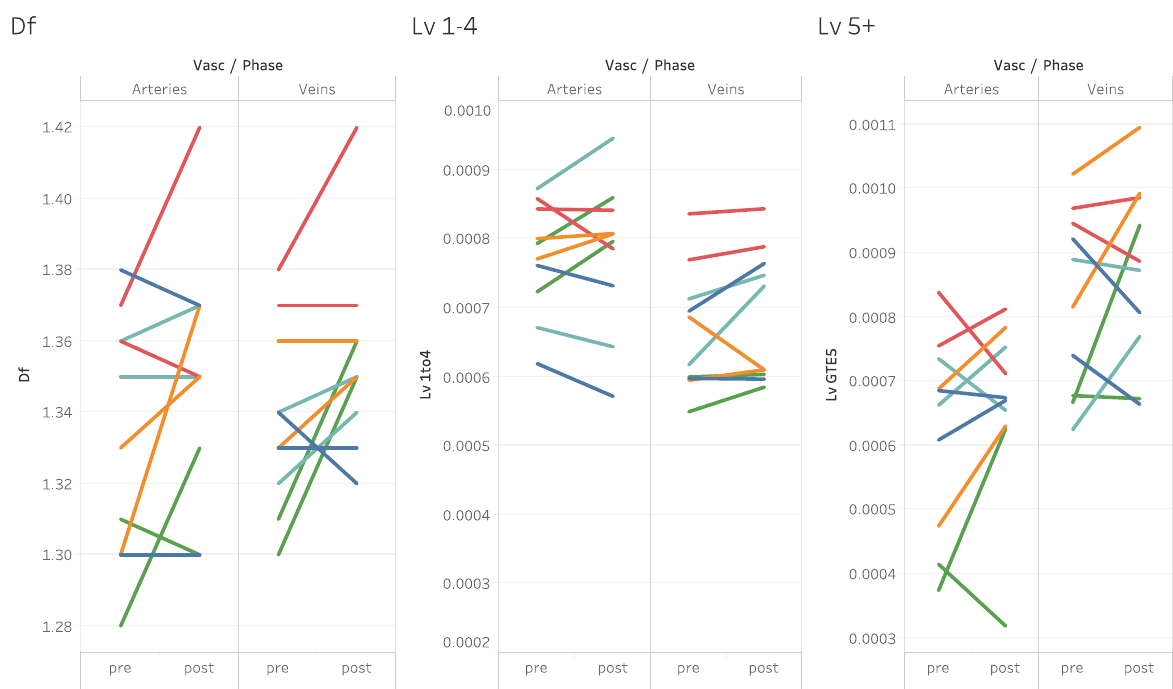
Fig. 5 Variability in vascular response of individual HDT subjects after 70 days of bed rest. Comparison of values of vascular parameters D f , L v1-4 , and L v>5 for each of the 10 de-identi fi ed retinas, and their pre-post change, before and after HDT. The two retinas of an individual subject are denoted by the same color. As hypothesized, the larger vessels ( L v1-4 ) did not remodel as greatly as the smaller vessels ( L v>5 ). The variability of retinal vascular response is consistent with the variability measured for other ocular changes in both astronaut and HDT populations such as ODE and retinal and choroidal thickness. In the L v1-4 column for veins, lower blue and orange bars overlap with green